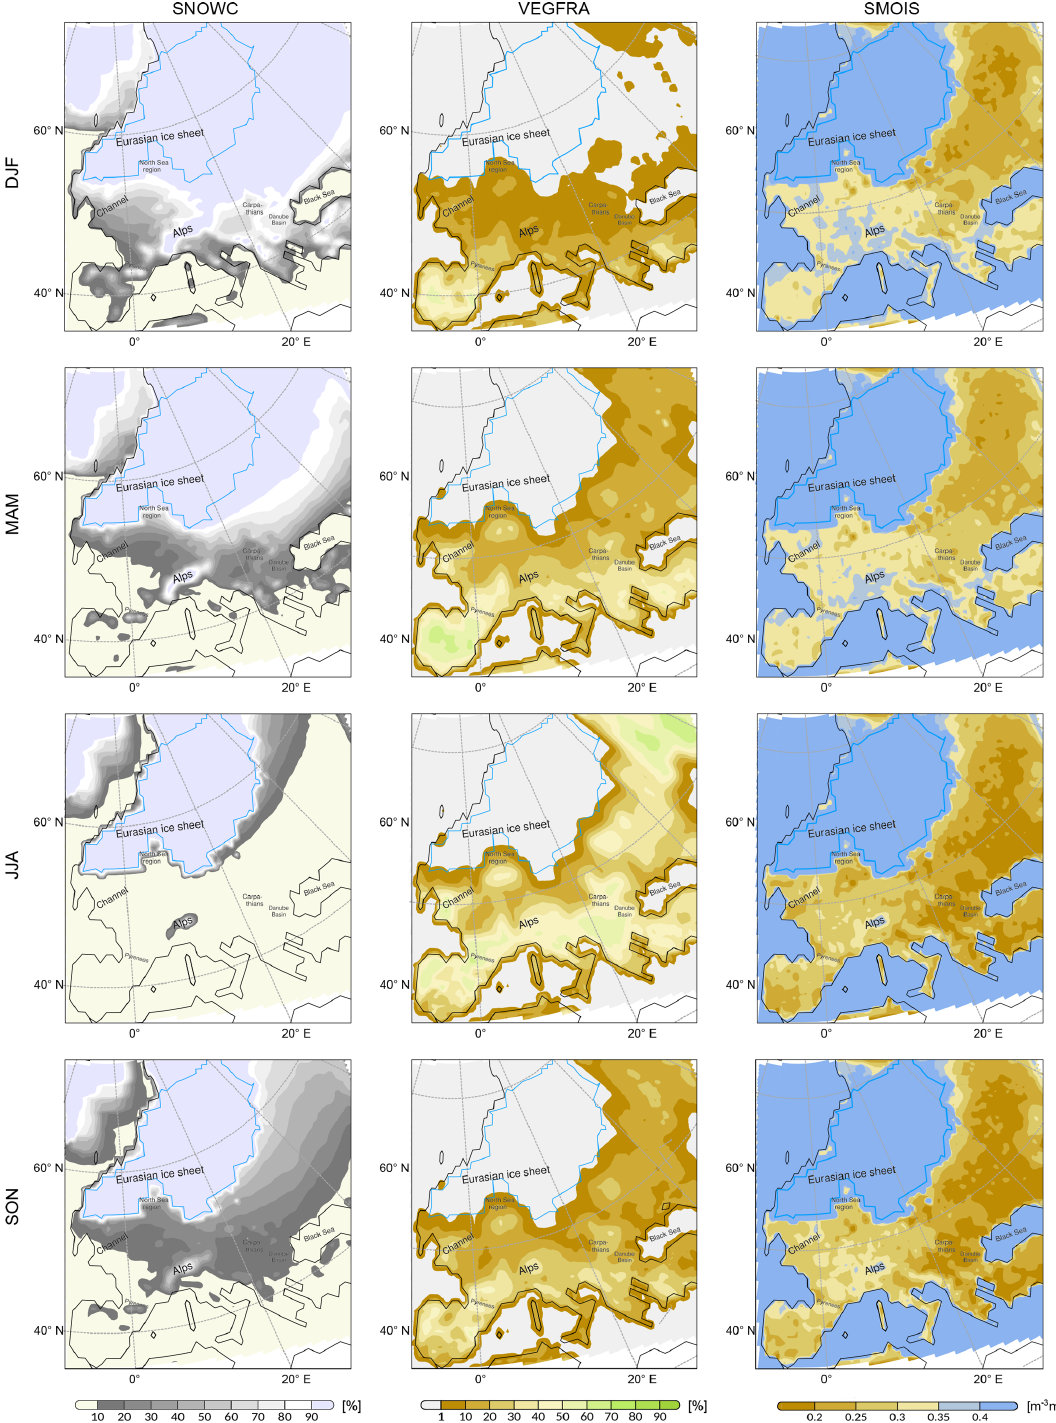
Figure 7. Snow cover (%, left column), vegetation cover (%, centre), and soil moisture (m 3 m − 3 , right), resolved for winter (DJF), spring (MAM), summer (JJA), and autumn (SON) for the Last Glacial Maximum. These reconstructions are based on dynamic